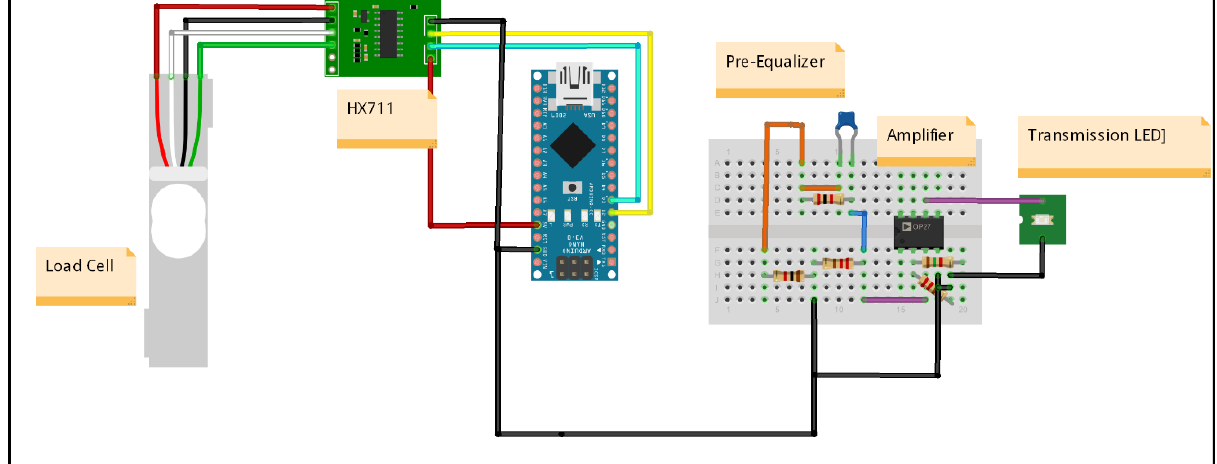
Figure 9. VLC tele-weight sending end schematic diagram.